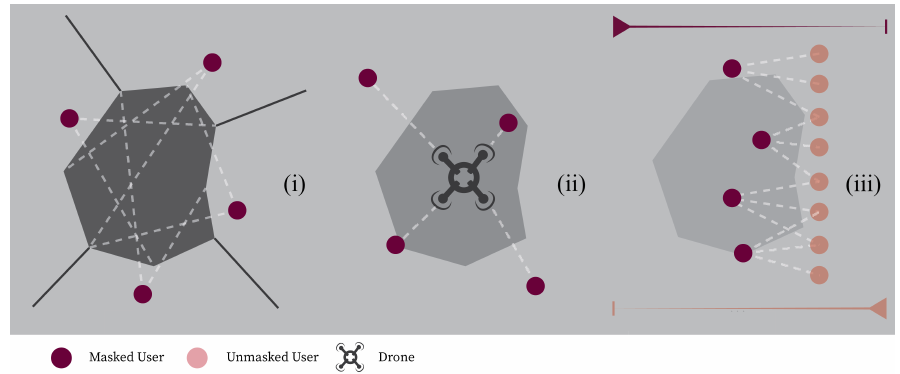
Figure 3. Visual representations for each scene. From left to right: (i) Geometric boundaries and interceptions, (ii) Interacting with the non-human, (iii) Participation from external